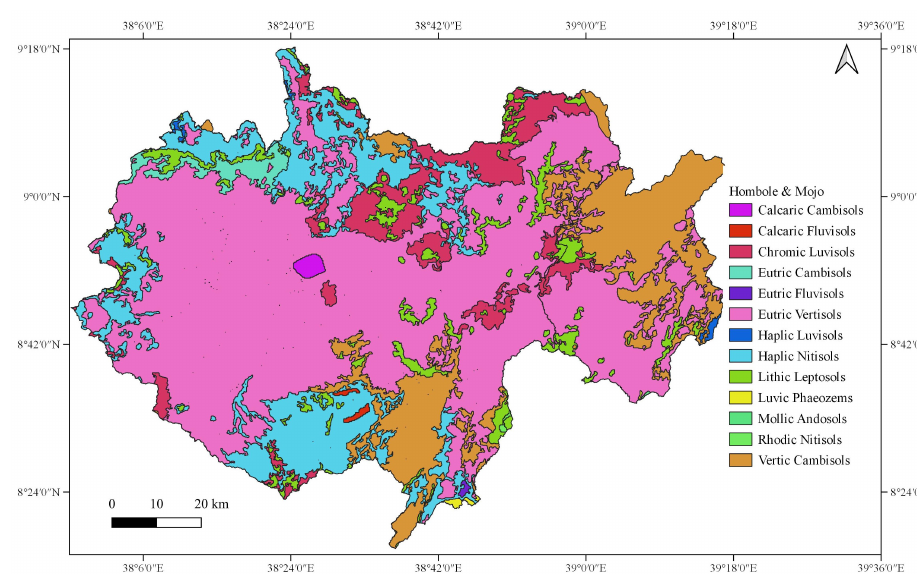
Figure A1. Soil maps of Hombole and Mojo watersheds.